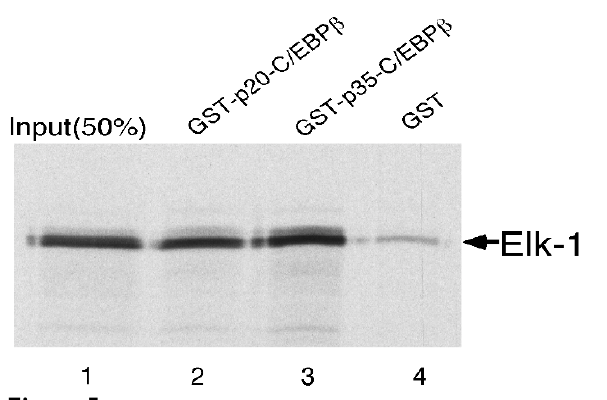
Figure 5 The C-terminal domain of C/EBP β interacts with Elk-1. Radi- olabeled Elk-1 was prepared by in vitro transcription and translation of CMV-Elk-1 expression construct and then incubated with equivalent amounts of GST, GST-p35-C/ EBP β , or GST-p20-C/EBP β protein immobilized on glutath- ione-Sepharose. Proteins eluted from the GST-p20-C/EBP β beads (lane 2), the GST-p35-C/EBP β beads (lane 3) or GST beads (lanes 4) were resolved on an SDS-10% polyacrylamide gel and detected by autoradiography. Lane 1 contains one- half of the amount of the radiolabeled proteins initially mixed with the beads.